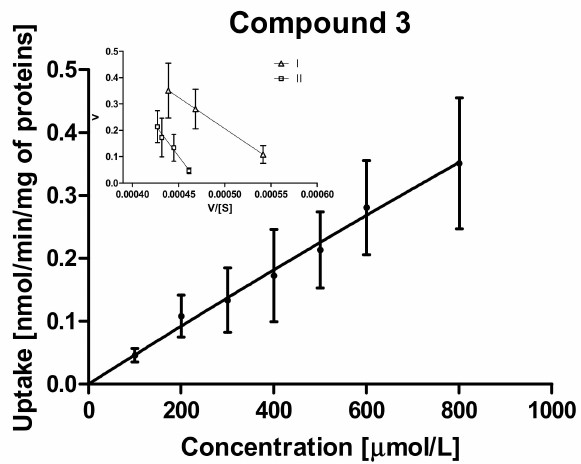
Figure 3. ( A ) The uptake of chloro-benzenesulfonamides ( 1 – 3 ) into MCF-7 cells at the concentrations of 10–3000 µ mol / L and Eadie–Hofstee plots for organic cation transporters’ (OCTs’) mediated transport. ( B ) The uptake of chloro-benzenesulfonamides ( 1 – 3 ) into MDA-MB-231 cells at the concentrations of 10–2000 µ mol / L and Eadie–Hofstee plots for OCTs’ mediated